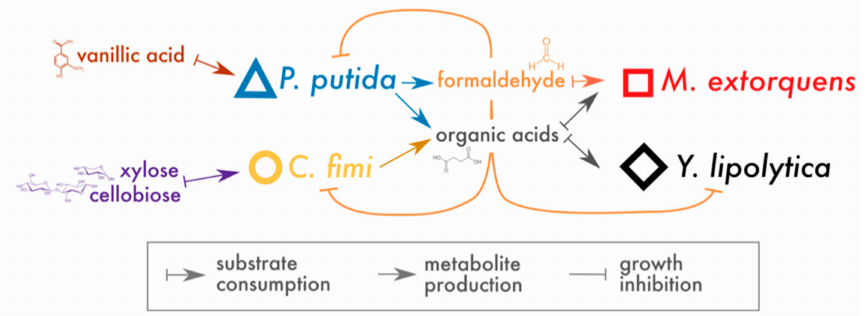
Figure 1. Conceptual model of interactions in the lignocellulose-degrading microbial consortium. Arrows indicate hypothesized interactions as described in the key. The colors and symbols used for compounds and species in this figure are the same as those used in data plots throughout the